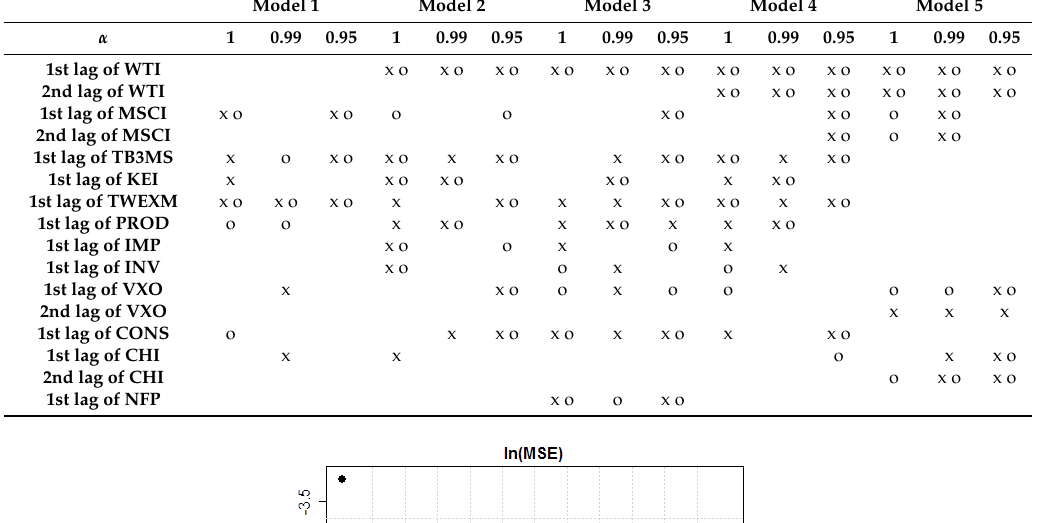
Table 3. “Reduced” models.